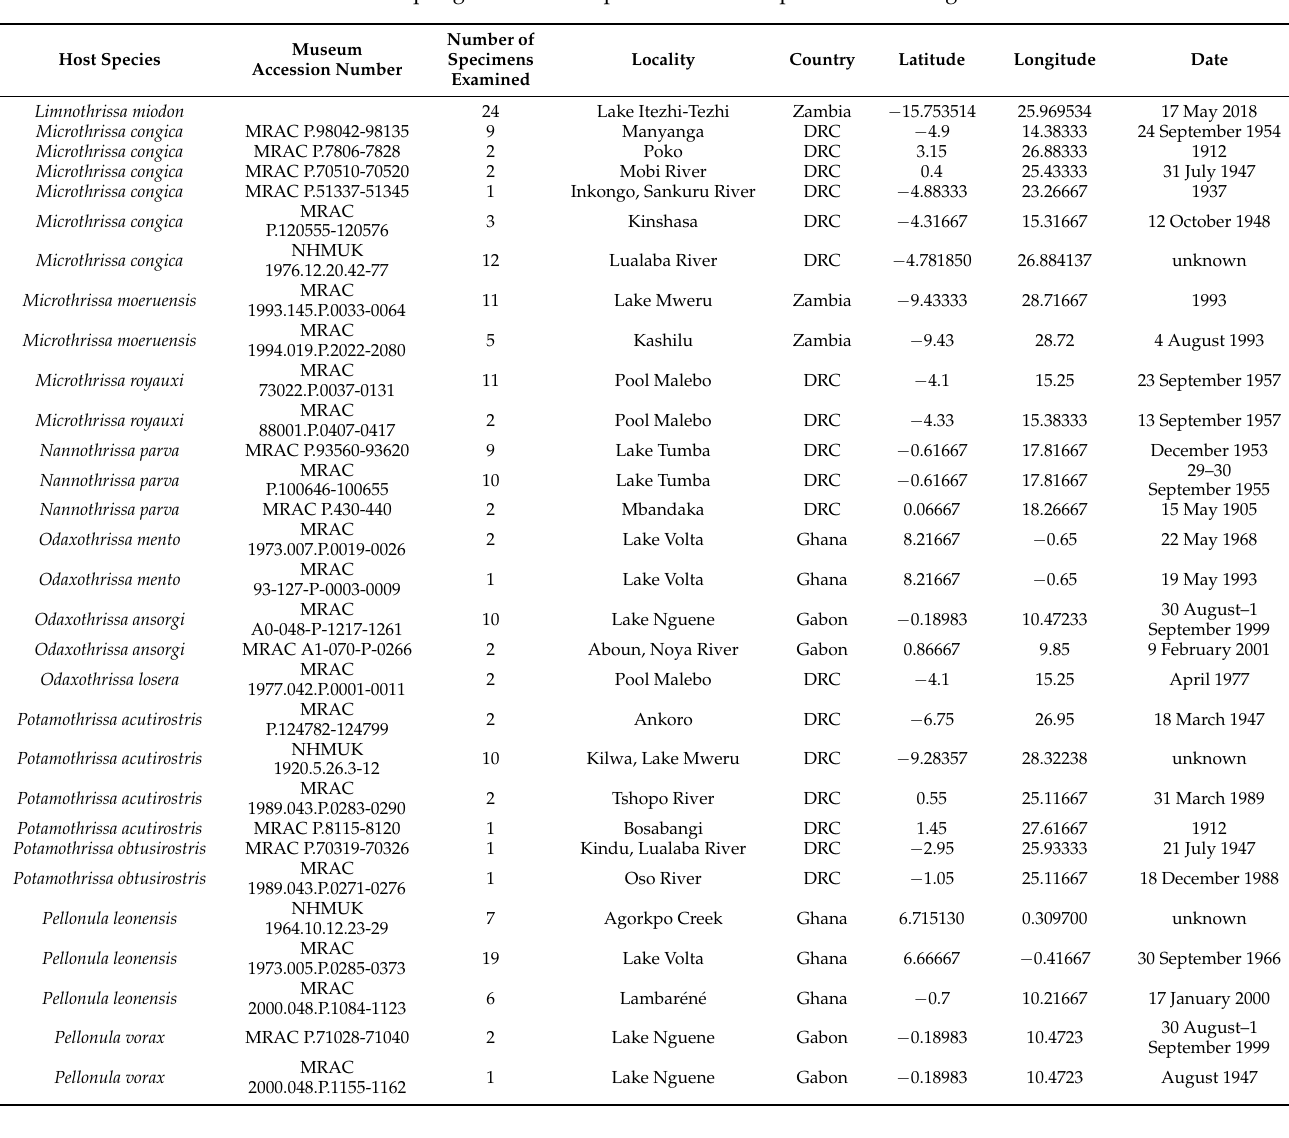
Table 1. Sampling details of the pellonuline host specimens investigated.